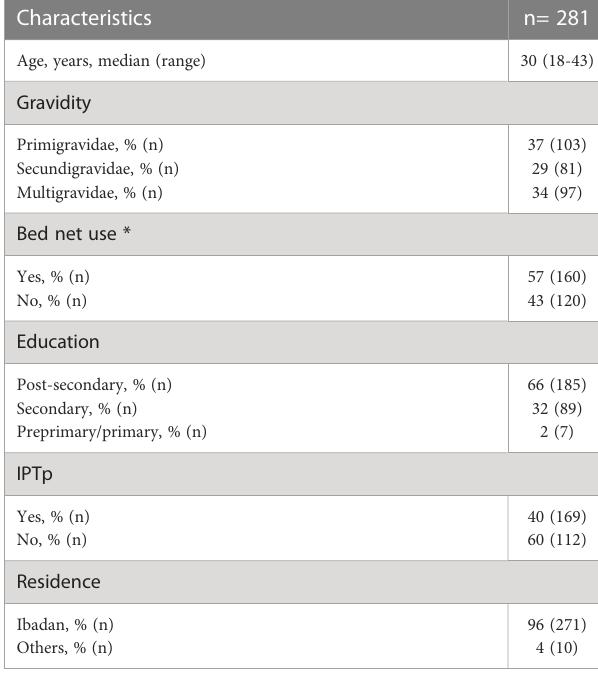
TABLE 1 Baseline characteristics of participants.